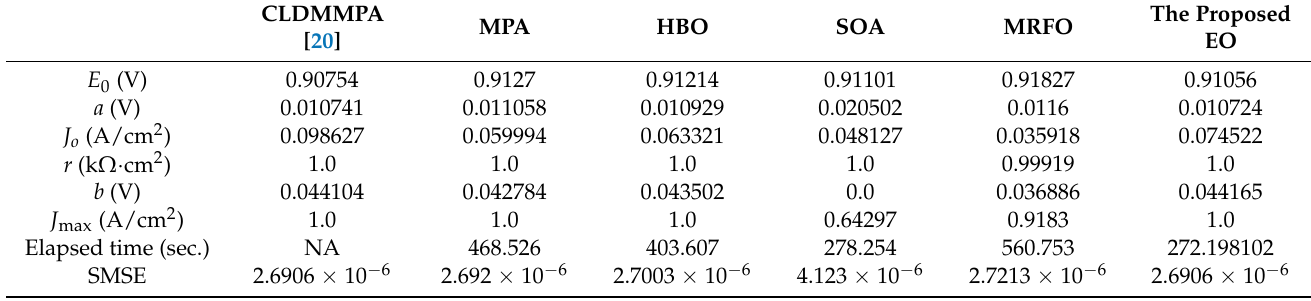
Table 1. The optimal parameters of SOFC steady-state based model operated at 1073 K.